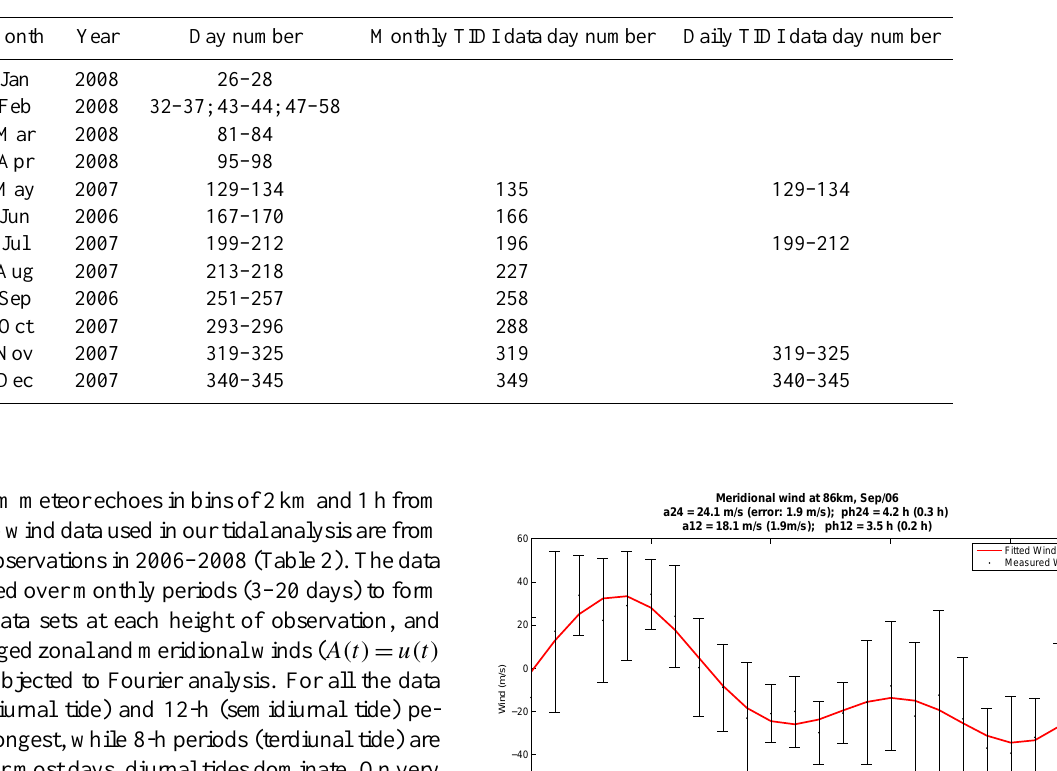
atures) and 7 nonmigrating (w4, w3, w2, s0, e1, e2, e3)